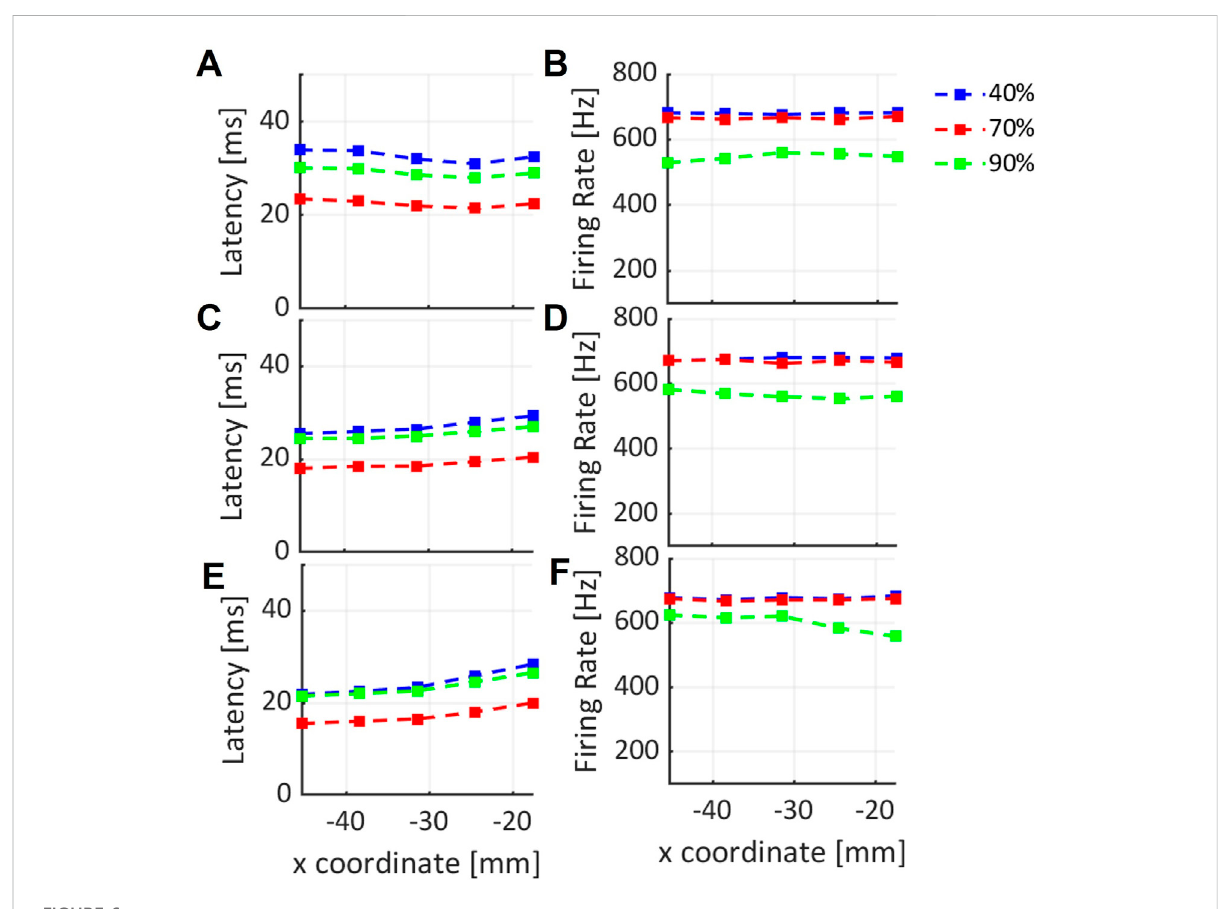
FIGURE 6 Variationoflatencyand fi ringrateofneuralcellresponsetotheultrasoundstimulusalongx-coordinate,forthreedifferenty-coordinates: (A – F) are related to y 1 , y 2 , y 3 values respectively, selected in the region of interest for three DC values shown in blue, red and green